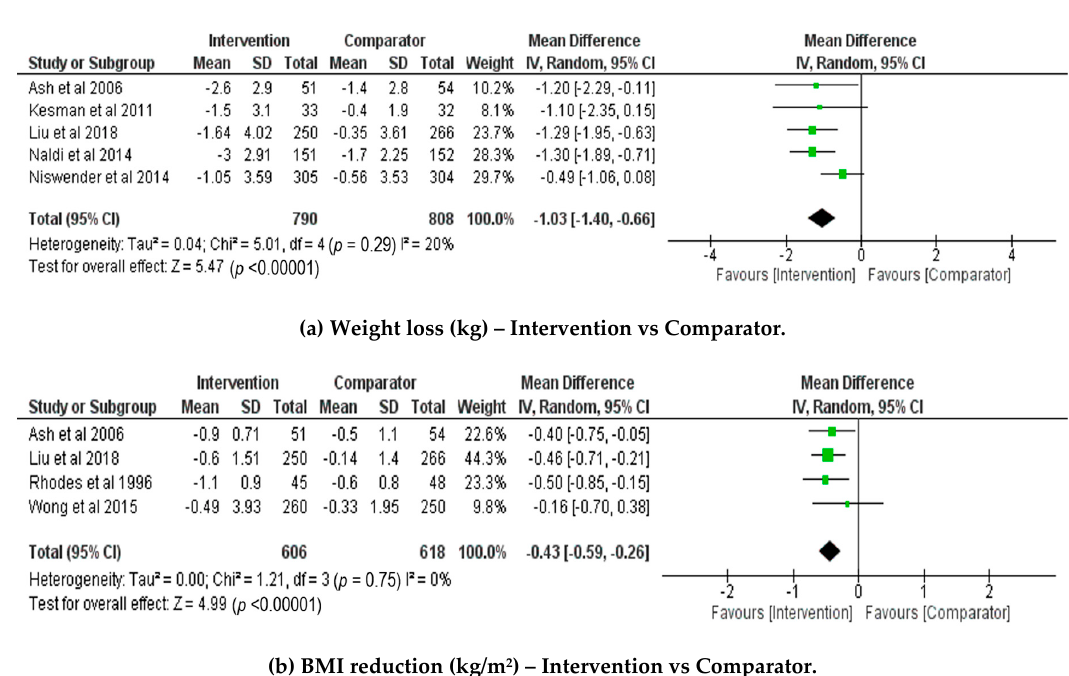
Figure 2. Forest plots showing the comparisons for individual dietetics counselling versus minimal or usual care from baseline to intervention end for ( a ) weight loss (kg) and ( b ) BMI (kg/m 2 ).